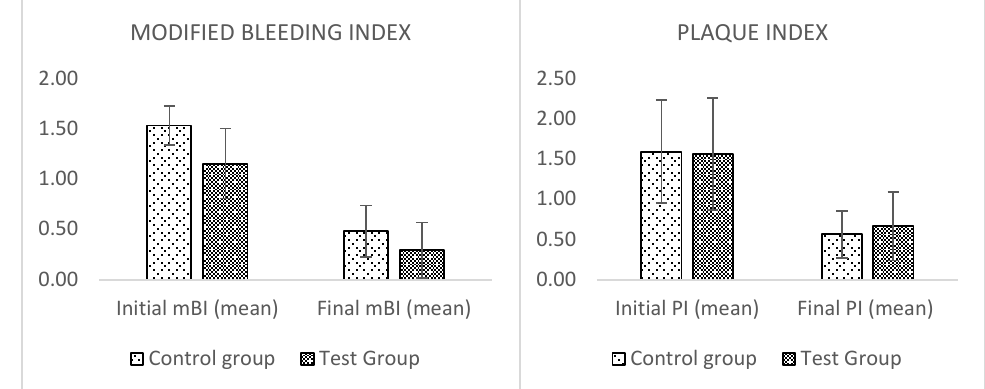
Figure 2. Graphs of the results. No significant difference was found in the two groups.